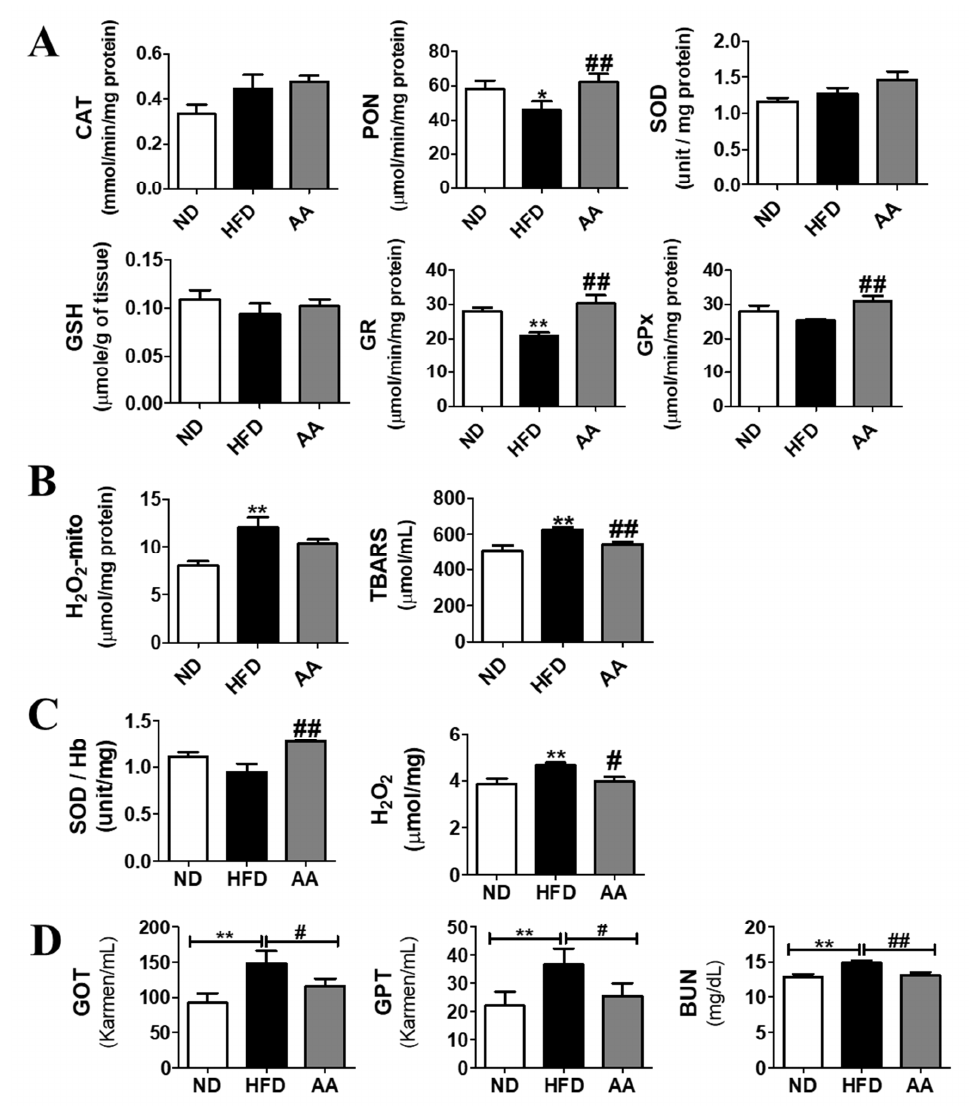
Figure 5. Effect of Artemisiae argyi water extract supplementation on diet-induced obesity. ( A ) Ac- tivities of hepatic antioxidant enzymes, ( B ) hepatic H 2 O 2 and TBARS levels, ( C ) erythrocyte SOD and H 2 O 2 levels and ( D ) plasma liver function index. Data are presented as the mean ± standard error of the mean. Significant differences between HFD versus ND are indicated as * p < 0.05, ** p < 0.01. Significant differences between the HFD and AA groups are indicated as # p < 0.05, ## p < 0.01. ND, normal diet (AIN-93G, n = 10); HFD, high-fat diet (60% kcal from fat, n = 10); AA, HFD + A. argyi water extract (1.5%, w/w , n = 10). CAT, catalase; PON, paraoxonase; SOD, superoxide dis- mutase; TBARS, thiobarbituric acid reactive substances; GOT, glutamic oxaloacetic transaminase;